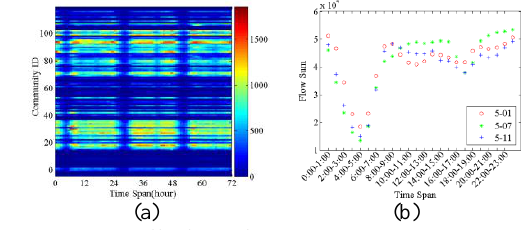
Figure 3. Traffic flow of communities in each period